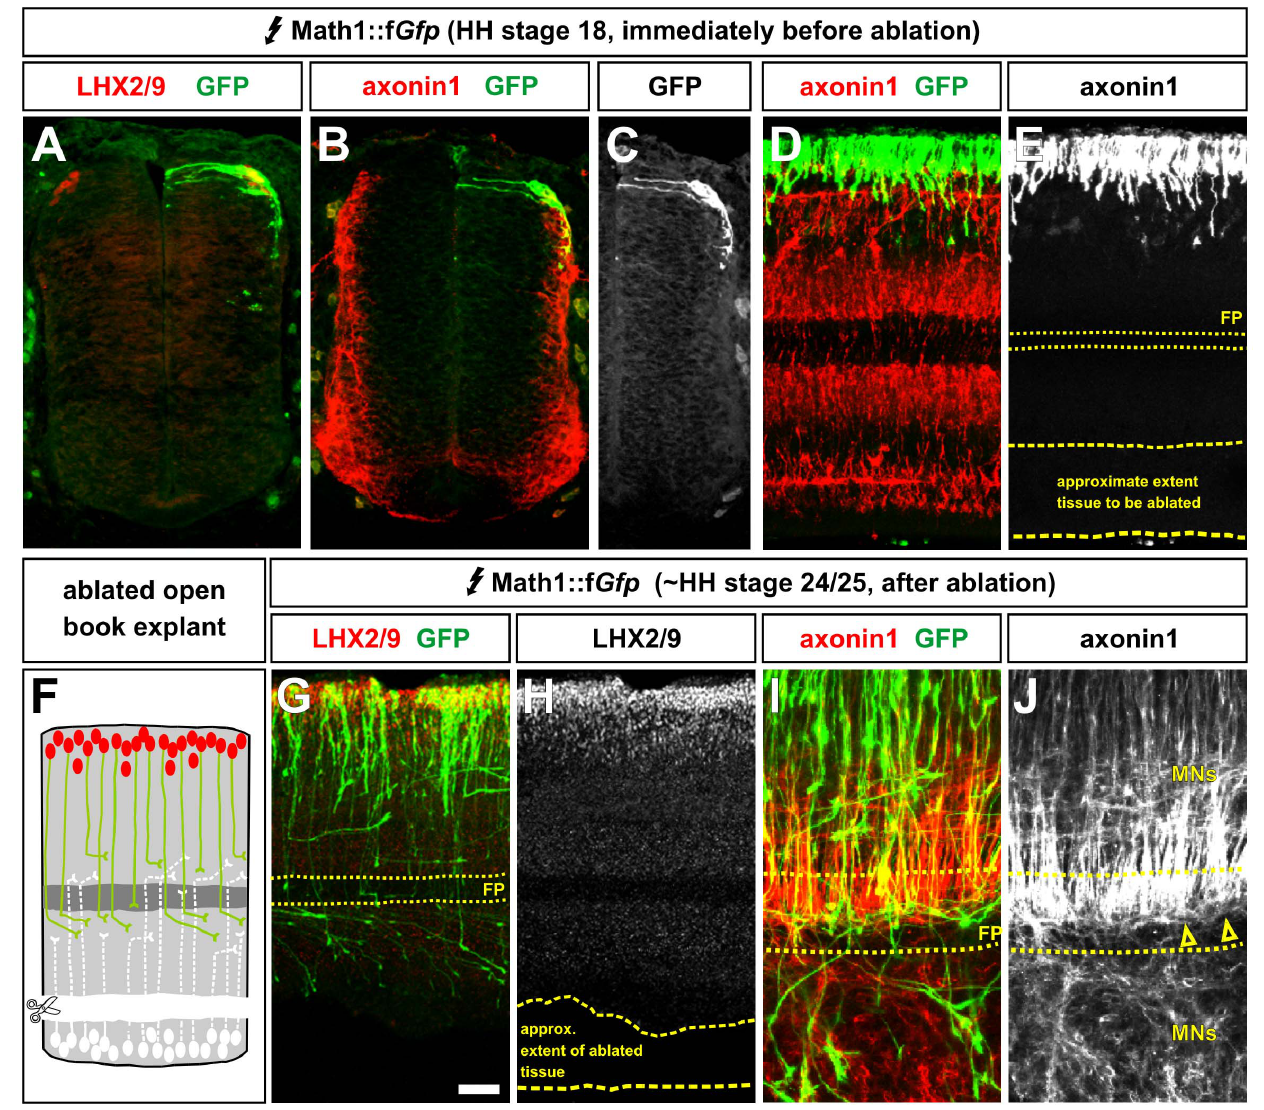
Figure 3. dI1 neurons can be unilaterally ablated in open book preparations of the spinal cord. (A–E) Chicken embryos were electroporated with a Math1::f Gfp expression vector at HH stages 14/15 and incubated until HH stage 18. To assess the extent of axon outgrowth transverse cross sections (A–C) or longitudinal open-book preparations (D, E) were labeled with antibodies against either LHX2/9 (A), which specifically labels dI1 nuclei [52,53] or axonin1 (B–E), which labels pre-crossing commissural axons as well as some motor axons [15]. At this stage, none of the dI1 GFP + axons (E) and very few of the axonin1 + commissural axons (D) have extended beyond the dorsal region that will be ablated. The axonin1 + processes in the ventral spinal cord appear to be emanating largely from the motor column. (F) The dorsal half of the spinal cord was unilaterally ablated at HH stage 18. Open book explants of the spinal cord were then cultured until , HH stages 24/25. (G–J) To assess whether the ablation of dI1 neurons was successful, the open-book preparations were labeled with antibodies against LHX2/9 (G, H) or axonin1 (I, J), which labels pre-crossing commissural axons as well as some motor axons [15]. In both cases, there was no evidence of any LHX2/9 + axonin1 + dI1 neurons remaining on the ablated side (H, J). Note that there is residual axonin1 staining in the motor neurons (MN) on both the unoperated and operated sides. Scale bar: (A–C) 30 m m; (D, E) 55 m m; (G, H) 70 m m; (I, J) 25 m m.